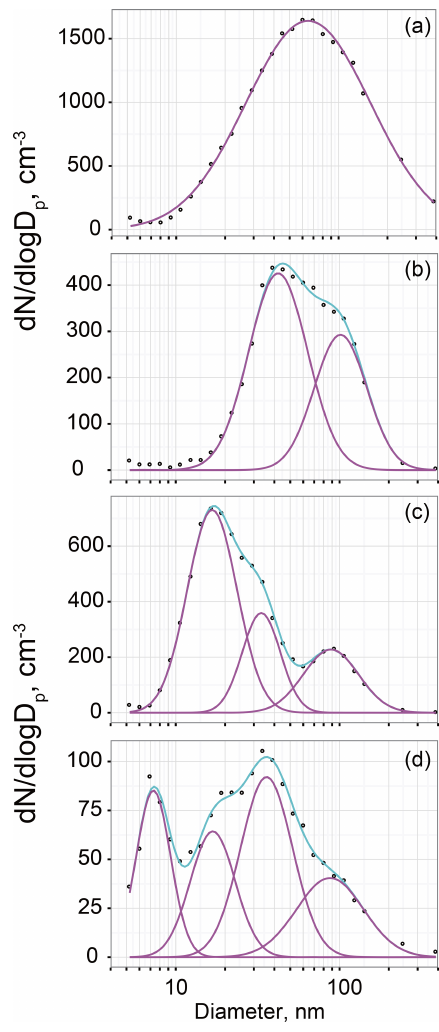
Figure 2. Examples of aerosol size distributions with (a) mono- modal (3 May 2005), (b) bi-modal (4 March 2005), (c) tri-modal (14 February 2005), and (d) quad-modal (8 September 2006) structures. Circles, pink lines, and cyan lines in (a) – (d) , respectively, show the observed data by SMPS, the number concentrations in each mode approximated by lognormal fitting, and total concentrations of the respective